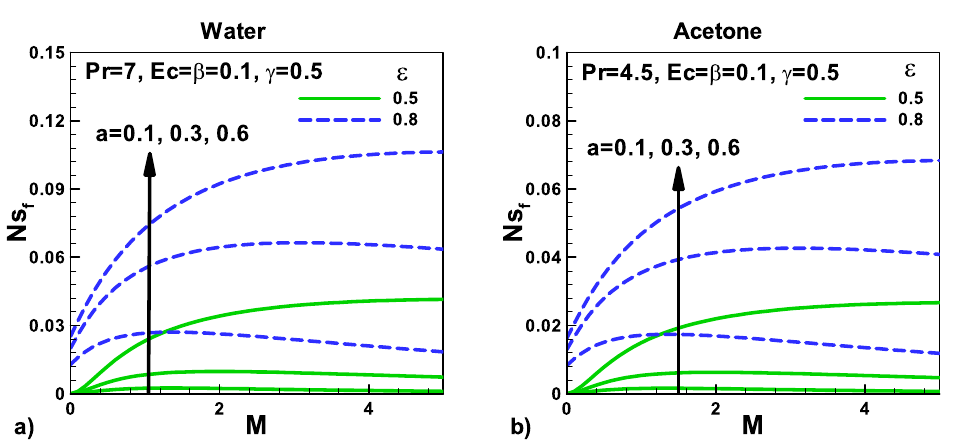
Figure 12. Variation of entropy generation rate due to friction with magnetic field and velocity ratio parameter at different positions for ( a ) water ( b )